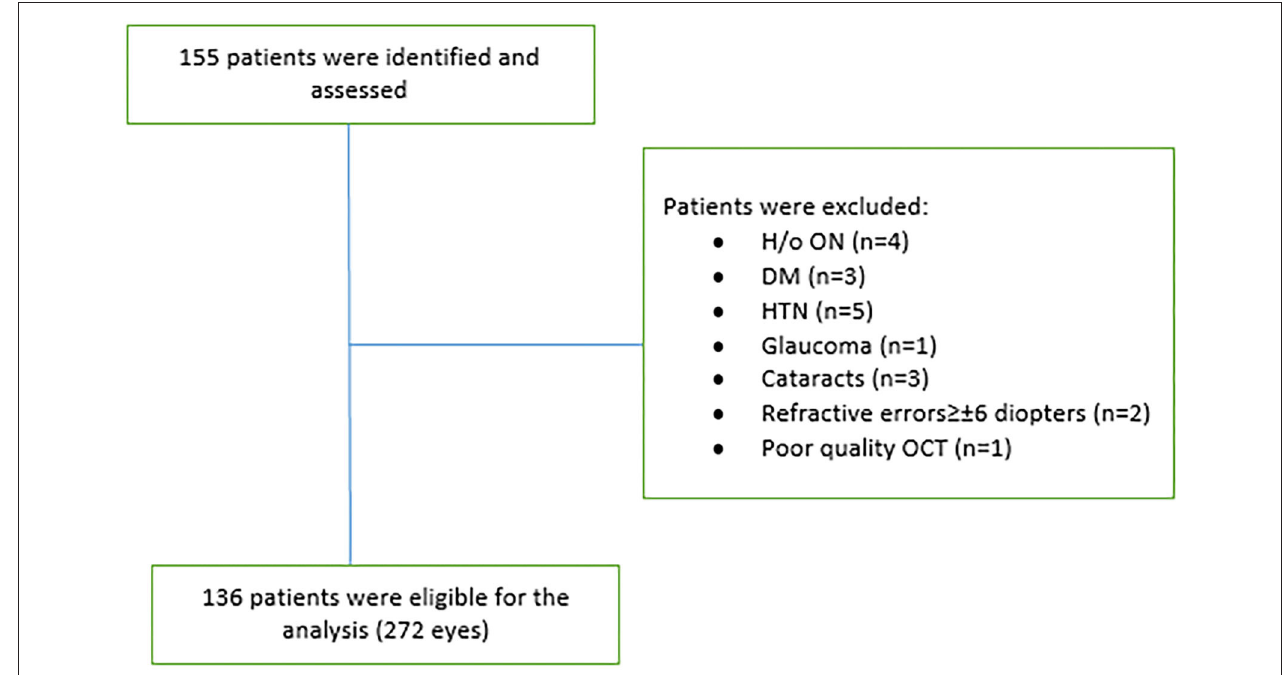
FIGURE 1 | Study profile. ON, optic neuritis; DM, diabetes mellitus; HTN, hypertension; OCT, optical coherence